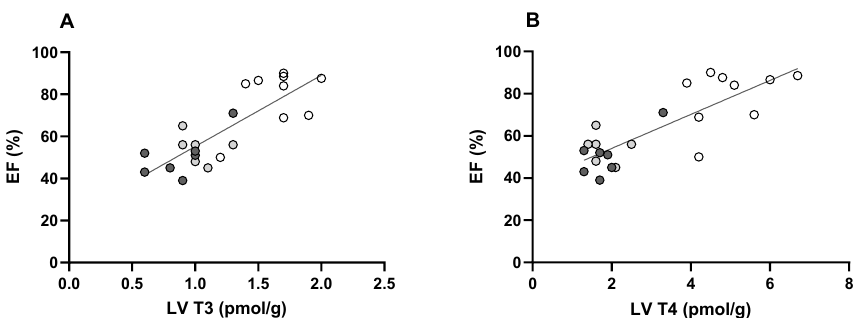
Figure 5. Ejection fraction as a function of LV tissue T3 content ( A ) and T4 content ( B ). Data are from Figure 3E (ejection fraction) and Figure 4C,D (LV T4 and T3). Regression lines: ( A ): R 2 = 0.66, slope 33.8 ( p < 0.0001); ( B ): R 2 = 0.67, slope 8.1 ( p < 0.0001). Symbols: CON: open; ISO + PE 1 wk: light grey; ISO + PE 2 wk: dark grey.